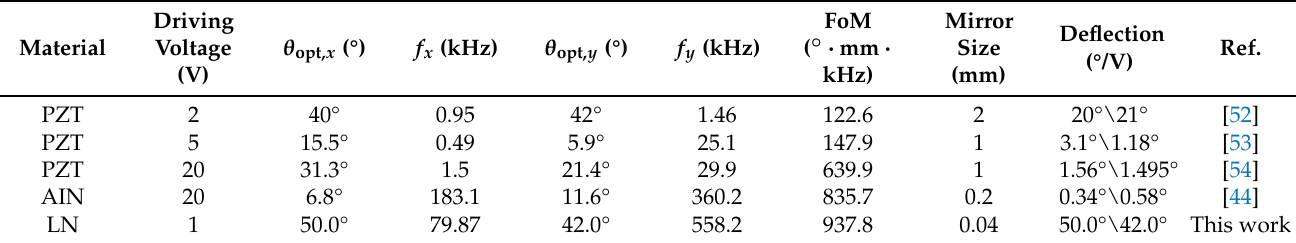
Figure 8. Mechanical deflection angle frequency response of fast and slow scanning modes. Table 2. Comparison between this work and state of